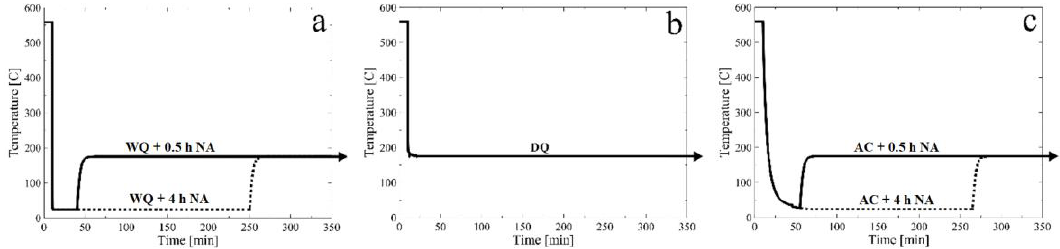
Figure 2. In-situ, time-temperature profiles corresponding to the five different heat treatments applied to all alloys, organized by solutionization cooling rate; water quench (WQ) ( a ); direct quench (DQ) ( b ); and ambient air cooling (AC) ( c ).